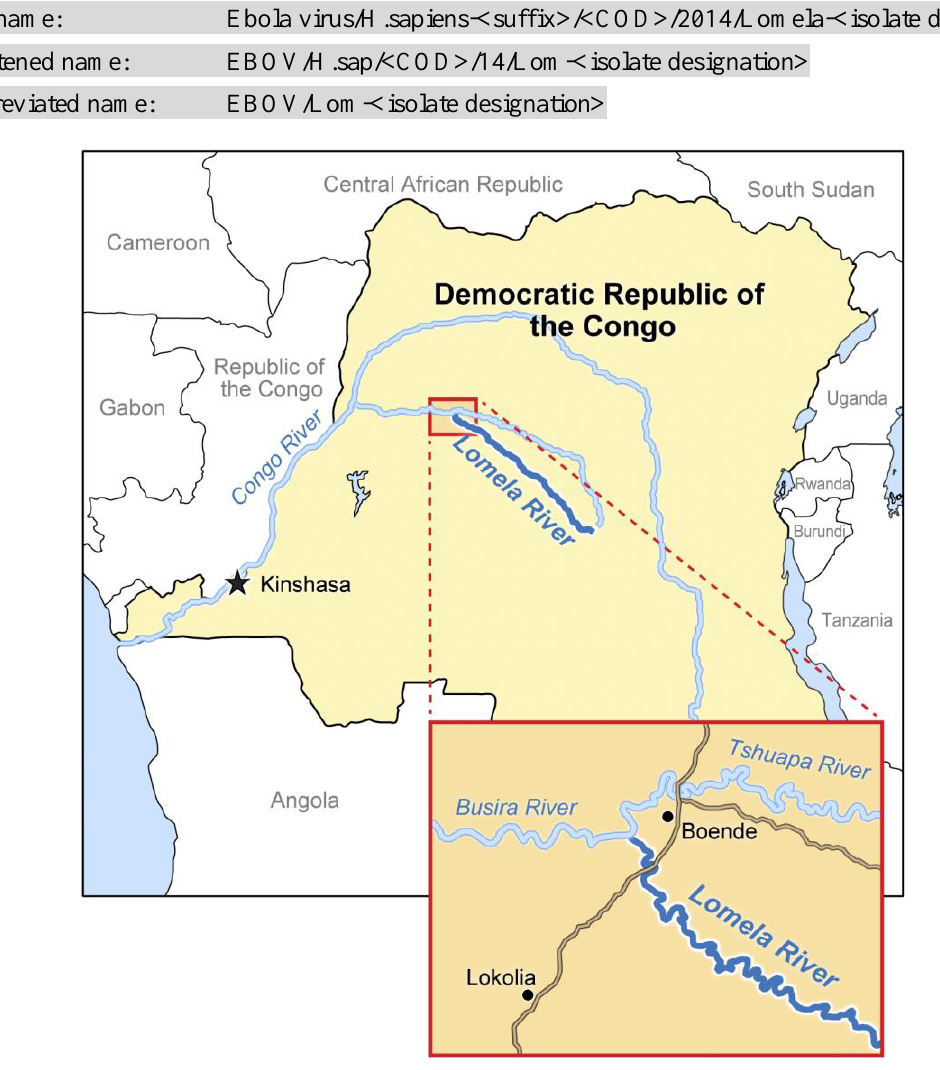
Figure 2. Location of the Lomela